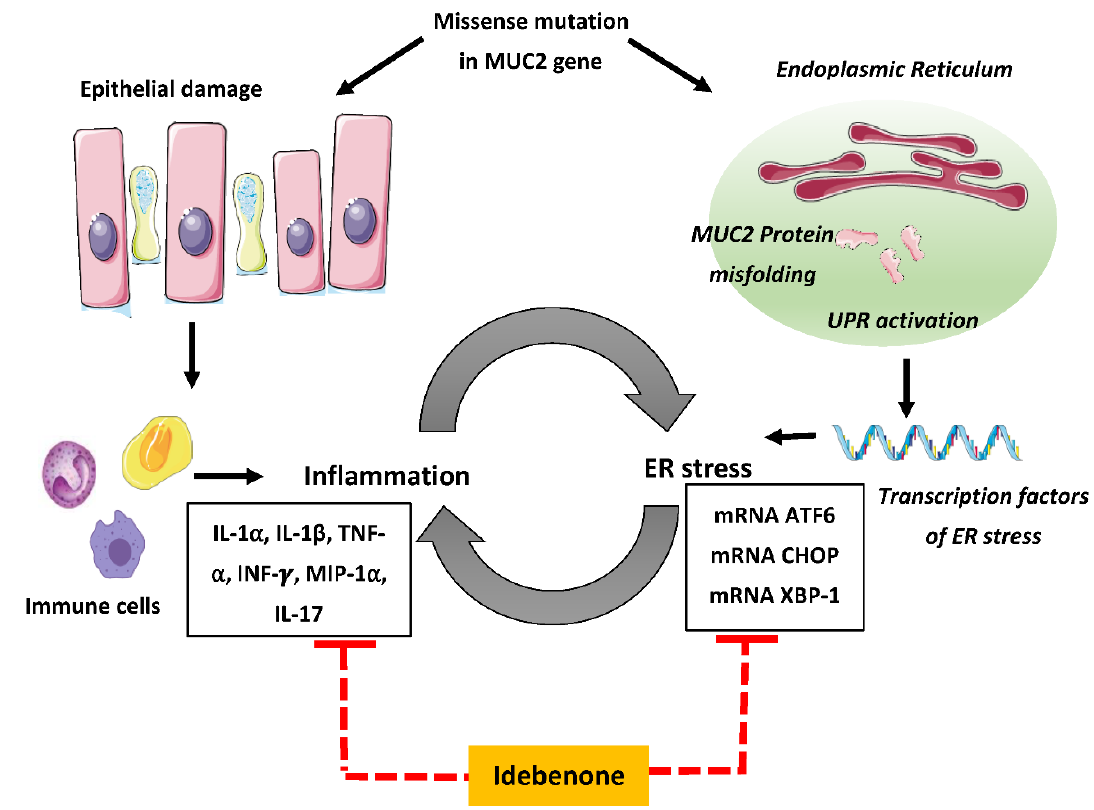
Figure 7. Schematic illustration of proposed mechanism of action of idebenone in chronic colitis. A missense mutation in the mucin MUC2 gene of secretory epithelial goblet cells damages the epithelial surface, reduces mucus production and provokes spontaneous inflammation. Inflammation exacerbates ER stress and UPR activation, creating a vicious cycle of chronic inflammation. The administration of idebenone for 3 weeks in Winnie restores MUC2 expression, lessens ER stress via suppressing the ATF6 / CHOP / XBP-1 axis and reduces elevated levels of pro-inflammatory cytokines. Idebenone protected against chronic intestinal inflammation in Winnie mice by suppressing ER stress and pro-inflammatory cytokines. ER: endoplasmic reticulum; IL: interleukin; TNF- α : tumor necrosis factor alpha; INF- γ : interferon gamma; MIP-1 α : macrophage inflammatory protein 1 alpha; UPR: unfolded protein response; ATF6: activating transcription factor 6; CHOP: C / EBP homologous protein; and XBP-1: X-box binding protein 1.